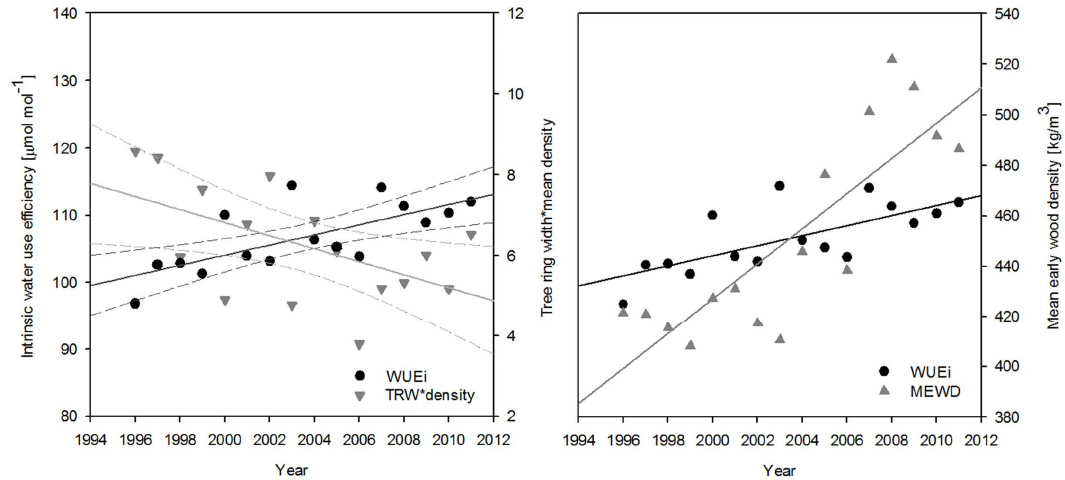
Figure 1. Trends of water use efficiency and tree-ring width multiplied by mean density as an indicator of productivity ( left ) and mean early wood density ( right ) over the 15 year investigation period for the Rheinhardsdorf provenance in Hohenleipisch.